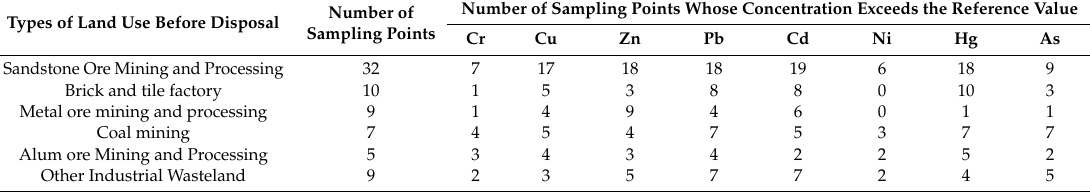
Table 7. The number of sampling points whose concentration exceeds the reference and its land use type.